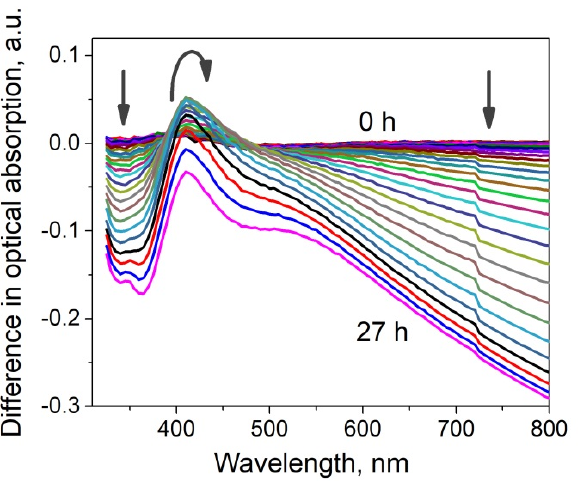
Figure 6. Dynamic changes of differential absorption spectrum of NPs-containing glass immersed in 2 mL of PBS buffer at 37 °C. The difference from the first spectrum of the kinetic series (45 s from the beginning of the reaction) is plotted. The spectra are taken with 1-h interval (0–27 h), arrows indicate the direction of changes. Table 3. Qualitative behavior of the samples after exposure to the buffers for 24